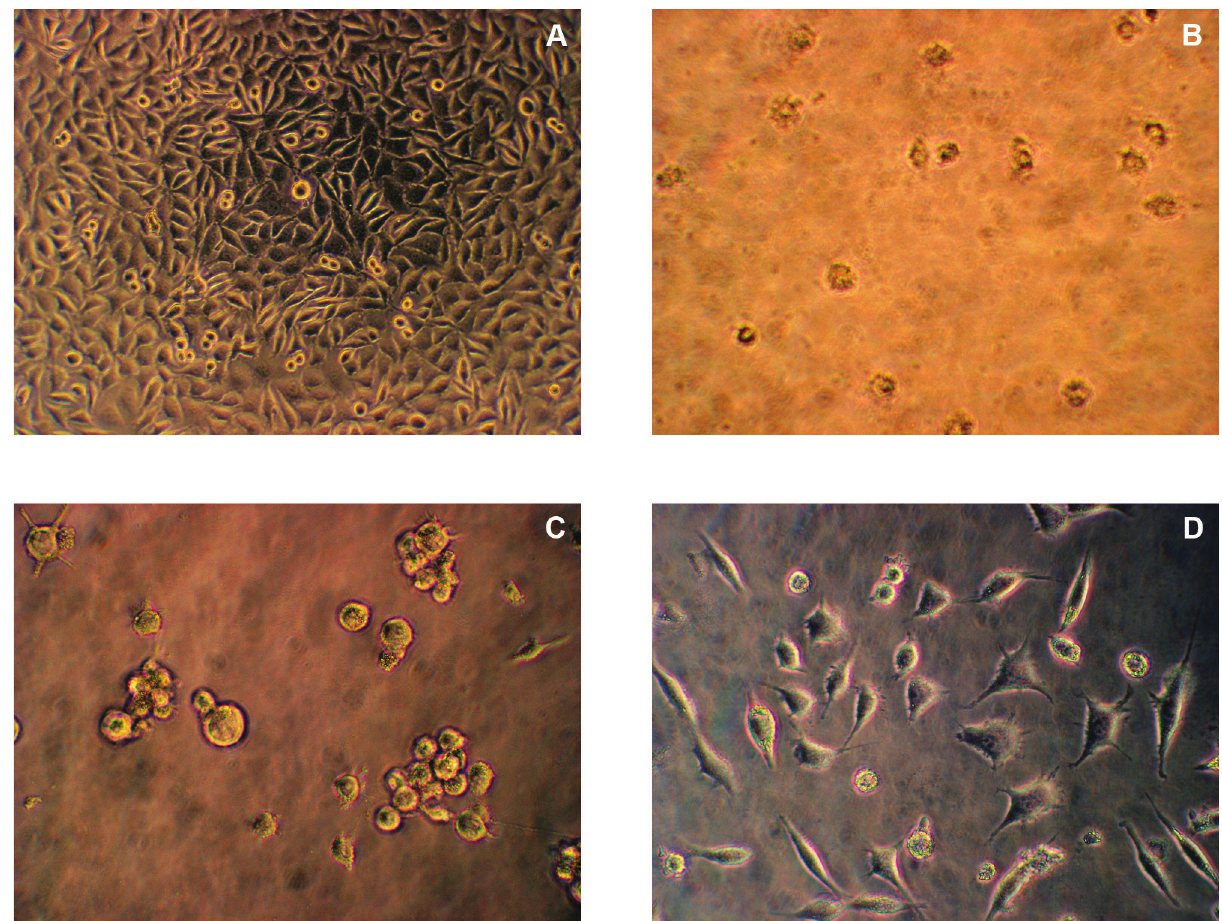
Figure 4. Morphological changes for L929 viewed by inverted microscope after venom treatment. ( A ) Untreated cells, ( B ) cells treated with 4.2 μg/mL, ( C ) cells treated with 1.1 μg/mL, and ( D ) cells treated with 0.13 μg/mL (magnification: